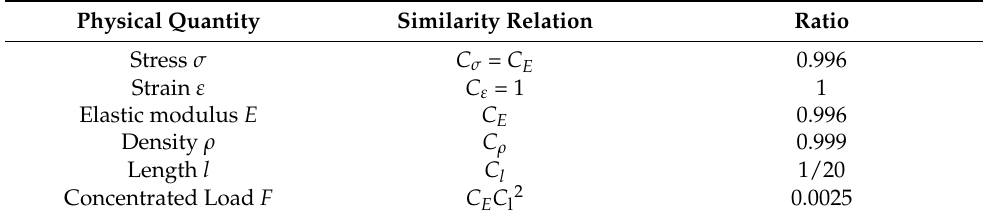
Table 1. Summary of similarity ratios of experimental